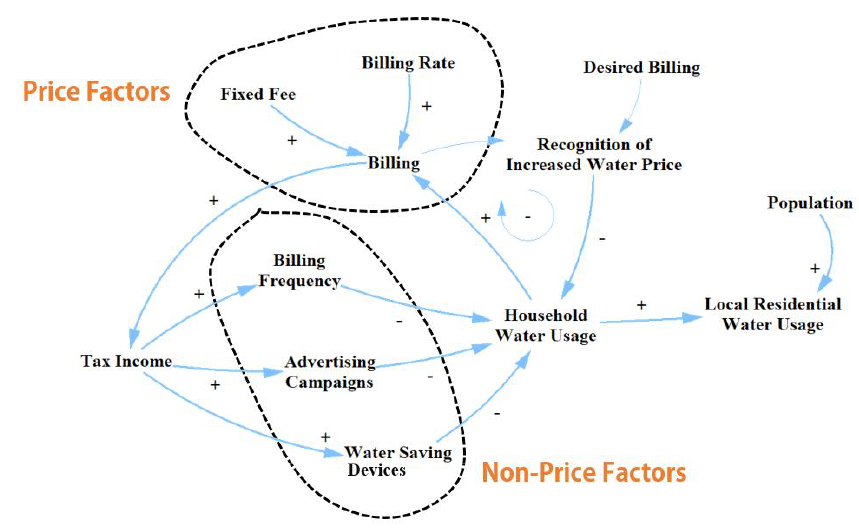
Figure 7. The SD model included price and non-price factors for saving residential water.